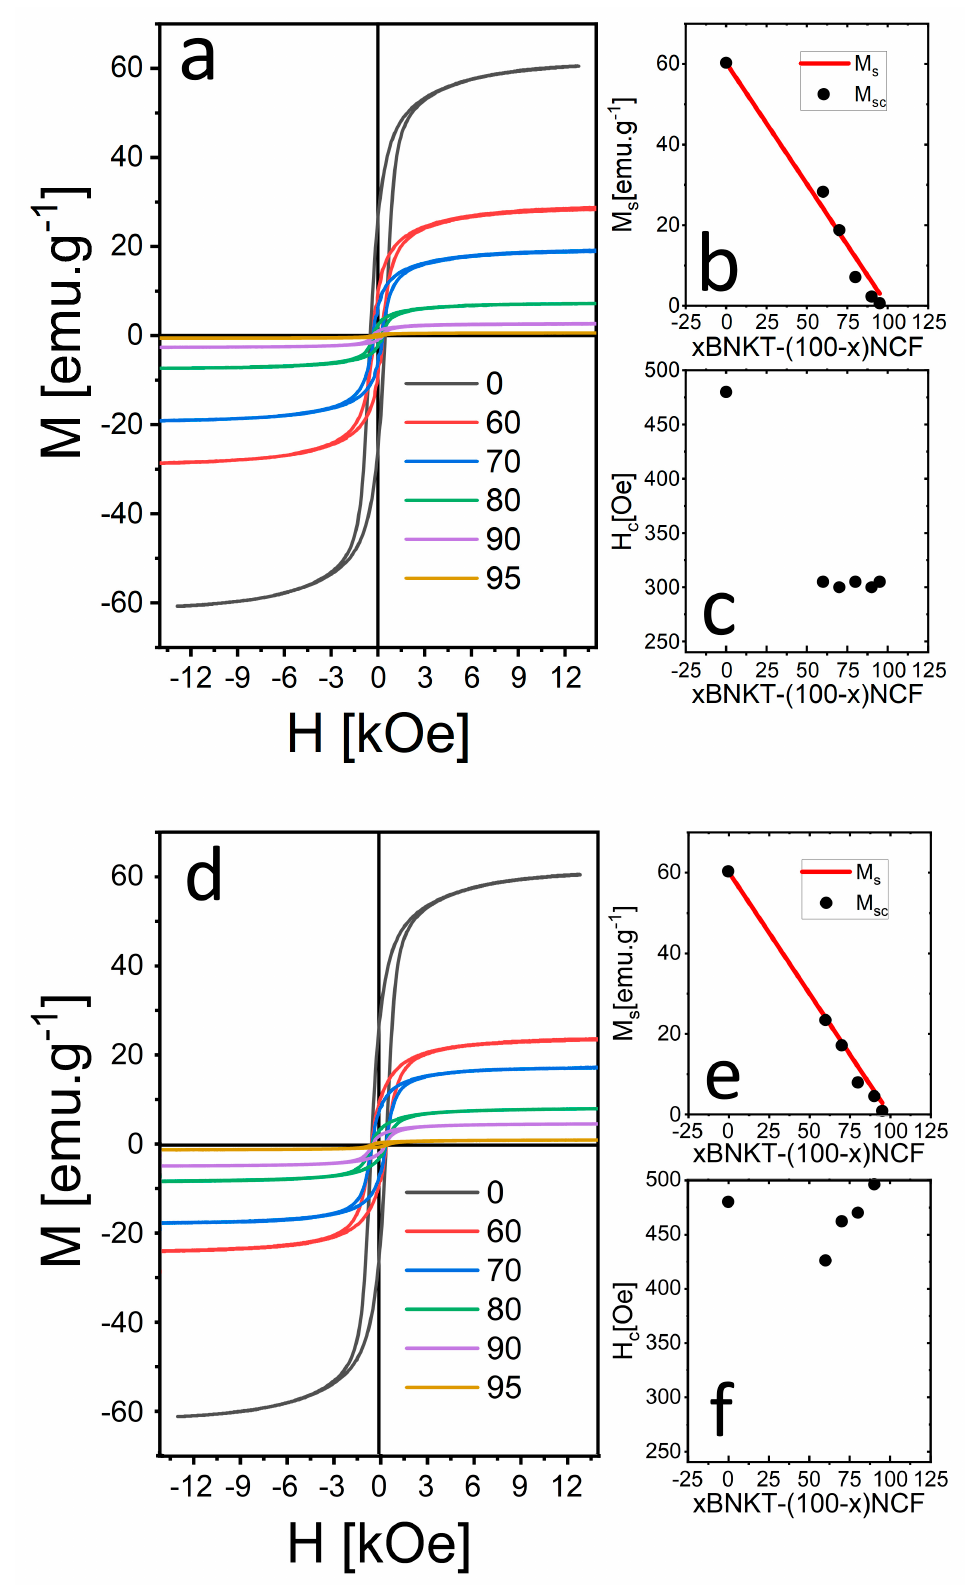
Figure 8. Magnetic hysteresis loops of the pure NCF sample and xBNKT-(100-x)NCF composites ( a , d ), Saturation magnetization ( b , e ) and coercive magnetic field ( c , f ) progress with composition. Table 4. Experimental (M s ) and calculated (M sc ) saturation magnetization and coercive fi eld (H c ) of